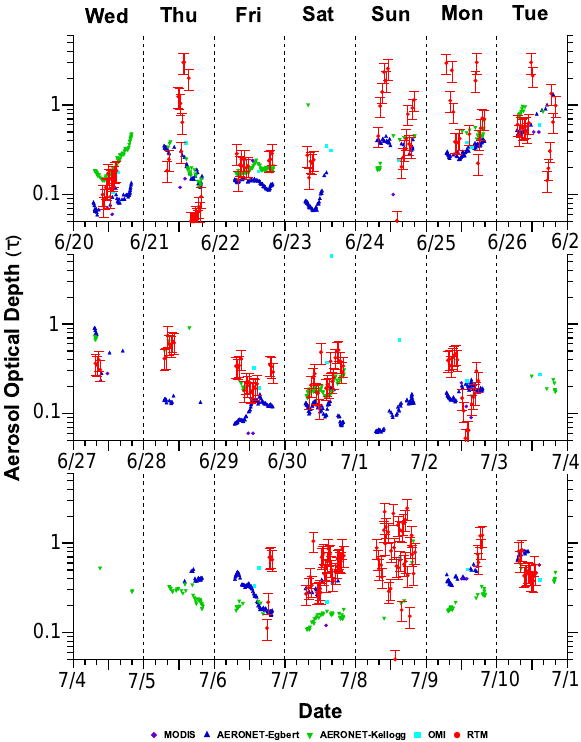
Fig. 4. O 4 DSCDs for cloud-free conditions during the BAQS-Met campaign at the Ridgetown supersite. Major ticks represent 12 mid- night and 12 noon EDT, while minor ticks indicate every 4-h incre- ment.